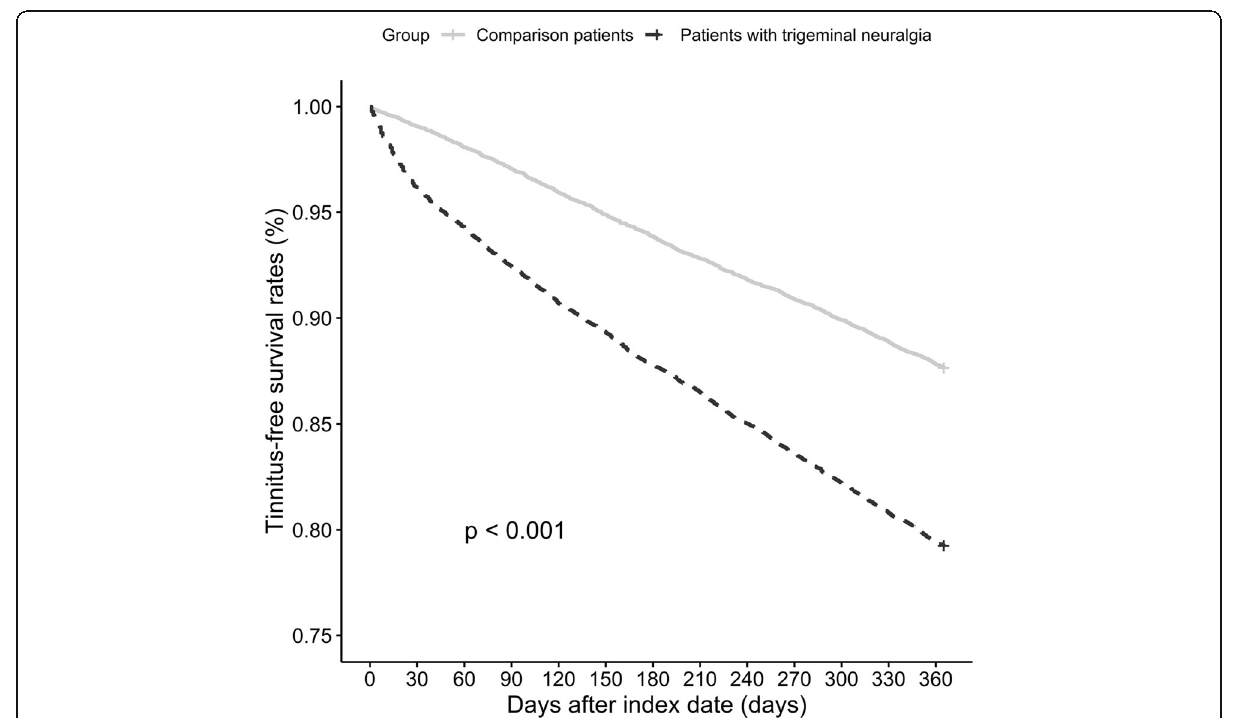
Fig. 1 Tinnitus-free survival rates for patients with trigeminal neuralgia and comparison patients (x axis = days after index date, y axis = tinnitus- free survival